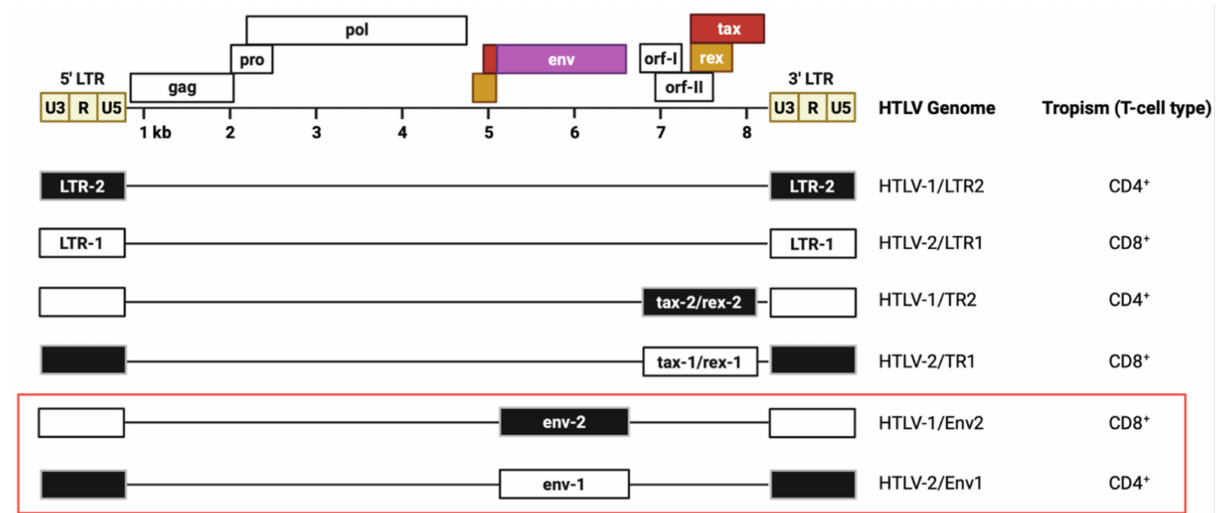
Figure 2. In vitro immortalization tropism of HTLV-1 and HTLV-2 recombinant proviral clones. Organization of the HTLV genome is depicted schematically, including the gag , pro , pol , env , tax , and rex genes in their respective reading frames, as well as orf-I and orf-II . For the recombinant proviral clones below, the altered region is indicated by white boxes (HTLV-1 origin) or black boxes (HTLV-2 origin), with the genetic background specified to the right. The immortalization tropism of CD4 + or CD8 + T-cells is shown for each virus. The red outline highlights recombinants which show a shift in T-cell tropism compared to the parental, wild-type